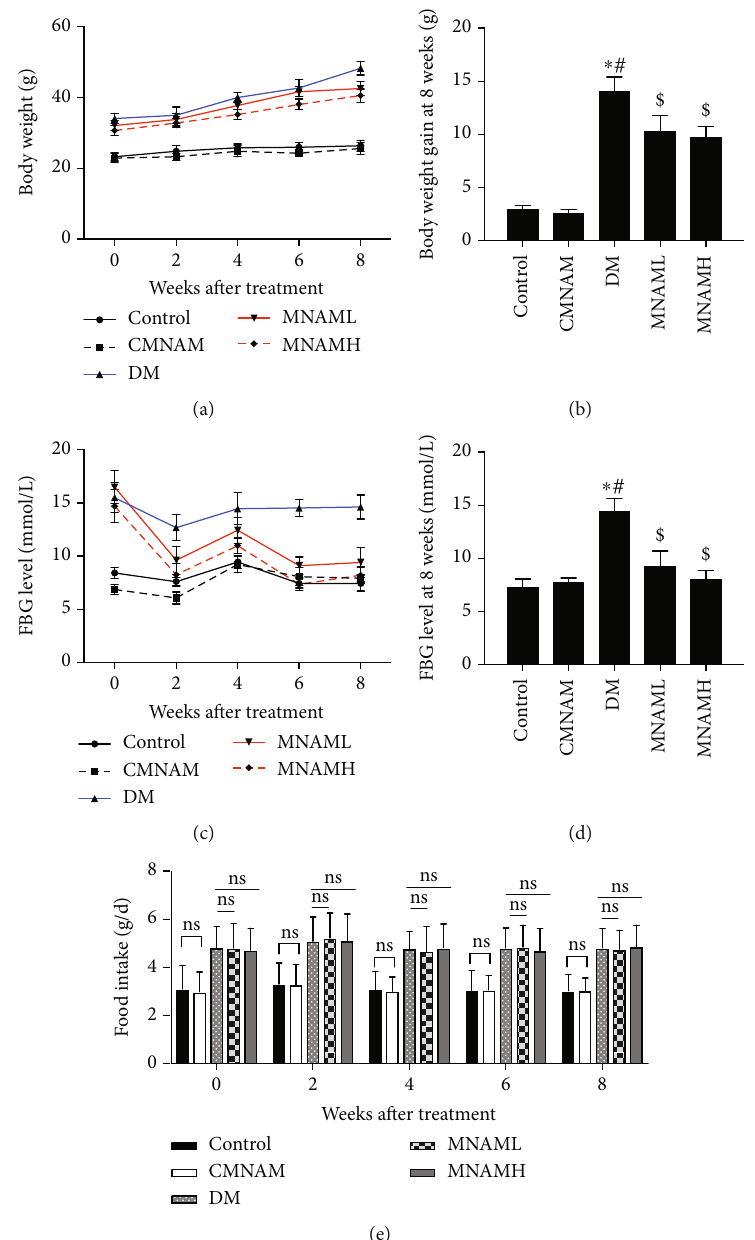
Figure 1: MNAM can reduce body weight and fasting blood glucose levels in obese type 2 diabetic mice ( n = 10 ). (a) Weights of mice in each group; (b) weights of mice at 8 weeks in each group; (c) fasting blood glucose of mice in each group; (d) fasting blood glucose of mice at 8 weeks in each group. ∗ Compared with the control group, P < 0 : 05 ; # compared with the CMNAM group, P < 0 : 05 ; $ compared with the DM group, P < 0 : 05 . (e) Average daily food intake of mice at 8 weeks in each group. ns: P > 0 : 05